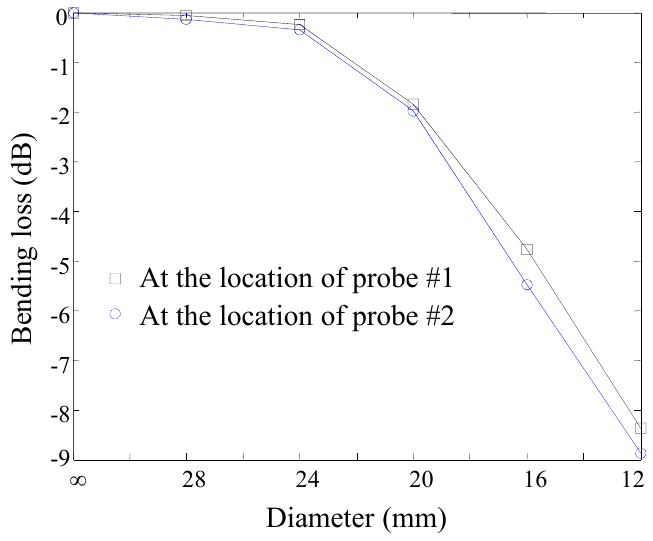
Figure 9. Bending loss according to winding one turn of an optical fiber, SMF-28, on a mandrel with various diameters.